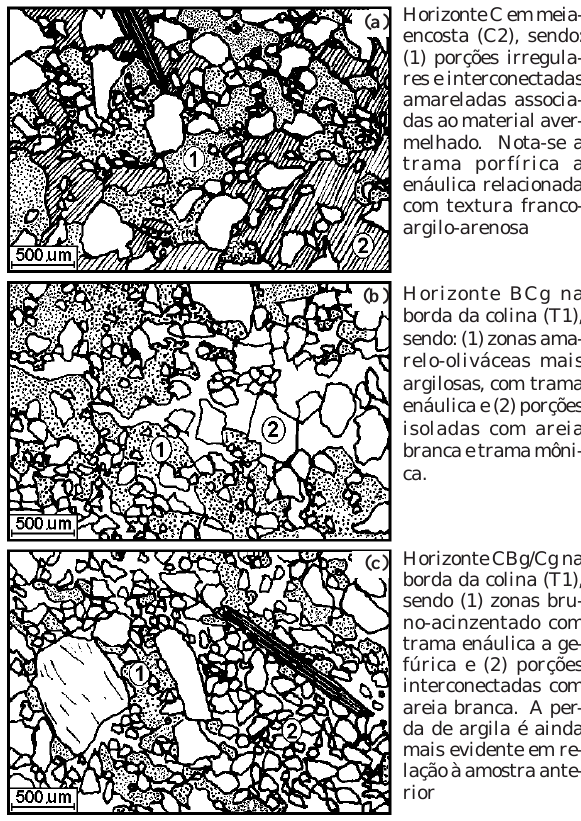
Figura 3. Representação esquemática da micro- estrutura dos materiais de alteração na porção superior (a) e na borda da colina (b, c).